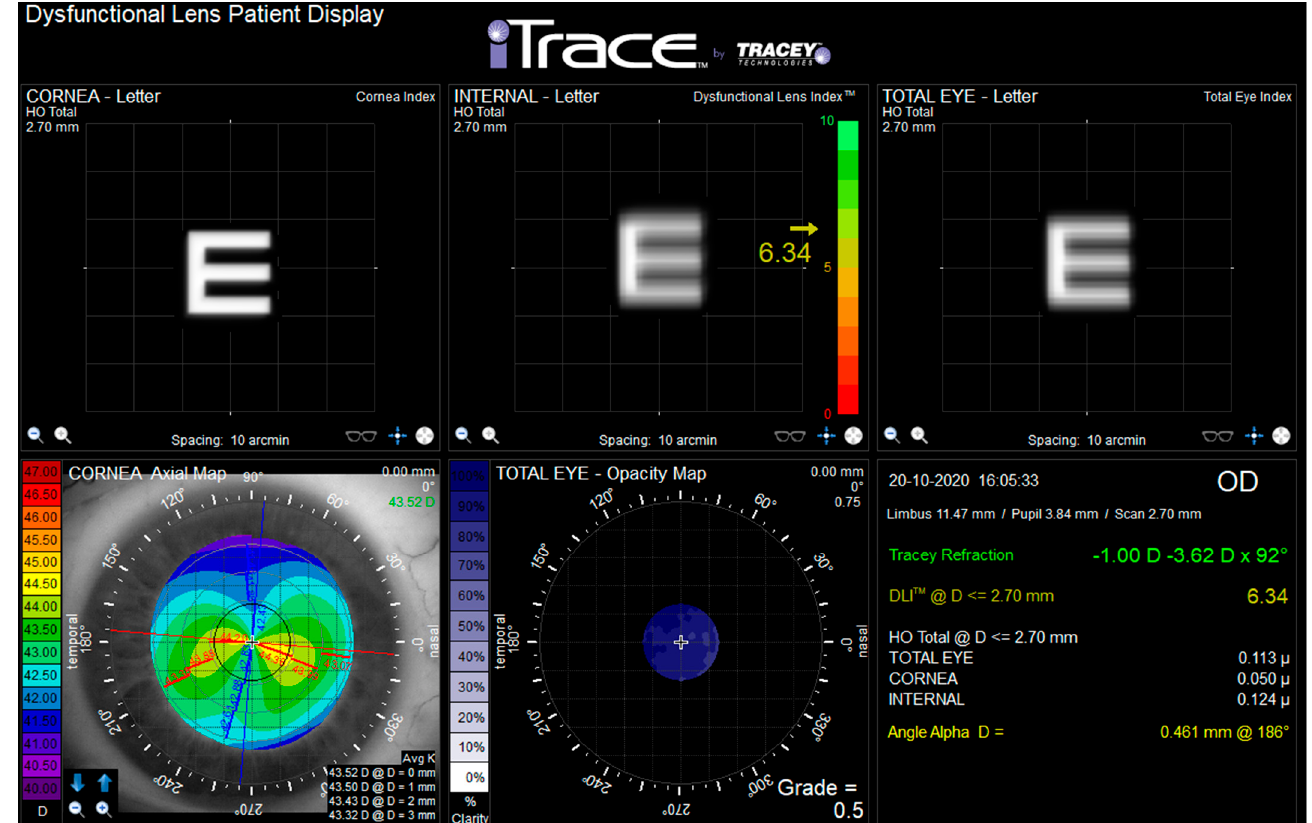
Figure 1. Dysfunctional lens patient display from i-Trace device. Dysfunctional lens index (DLI) is shown in yellow font in the top middle box. Opacity grade is shown in white font in the bottom middle box.